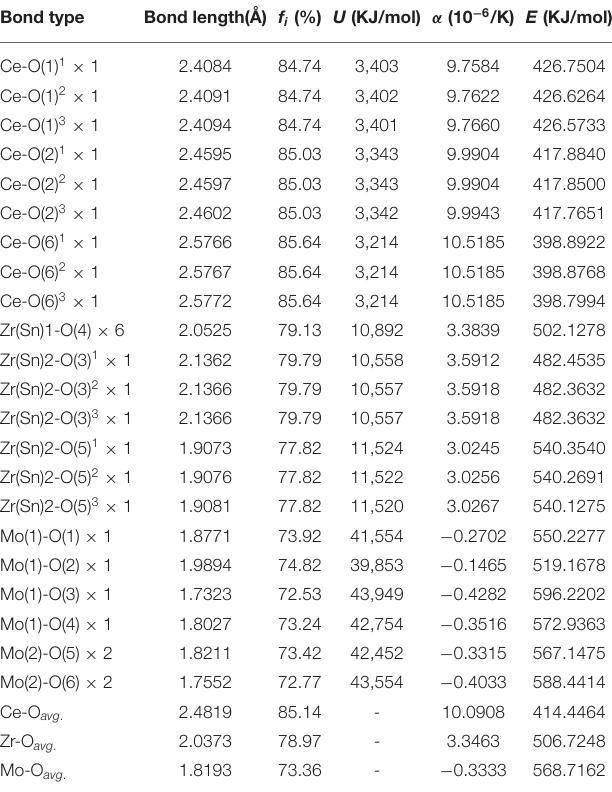
TABLE 2 | Band ionicity f i , lattice energy U , bond energy E, and coefficient of thermal expansion α of each bond for Ce 2 (Zr 0.94 Sn 0.06 ) 3 (MoO 4 ) 9 ceramic sintered at 800 ◦ C.